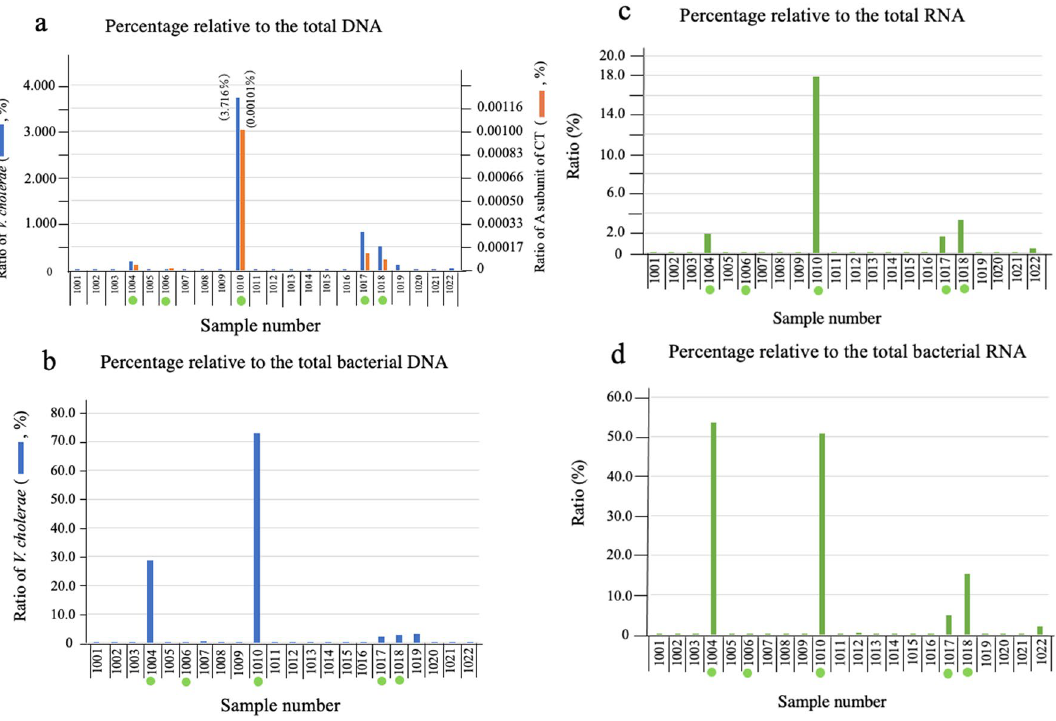
Figure 6. The ratio of DNA and RNA derived from V. cholerae in stool samples of the specific-pathogen-free patients. The stool samples from 22 diarrheal patients in which no etiological agent of diarrhea, including V. cholerae , was detected by our bacterial examination in the laboratory were analyzed in this examination. The extraction of DNA and RNA, and the preparation of reverse-transcribed DNA samples from the RNA samples were performed in the same manner as in Fig. 2. The origin of the reads obtained in this analysis was assigned by mapping to a database that included human and microorganism sequences. The obtained numbers of total reads, total bacterial reads, reads originating from V. cholerae, reads from ctxA in each sample are shown in Supplementary Tables S5 (the data from DNA) and S6 (the data from RNA). The percentages of reads of DNA from V. cholerae (blue bar in a ) and of reads of DNA from ctxA (red bar in a ) relative to the total DNA reads, and the percentages of reads of DNA from V. cholerae relative to the total bacterial DNA reads ( b ) are presented. Similarly, the results obtained from the RNA samples are presented in ( c ) and ( d ). The ( c ) and ( d ) show the percentages of reads of RNA from V. cholerae relative to the total RNA reads and to the reads of total bacterial RNA, respectively. The samples indicated by green circles are the samples of interest in this manuscript, as described in the